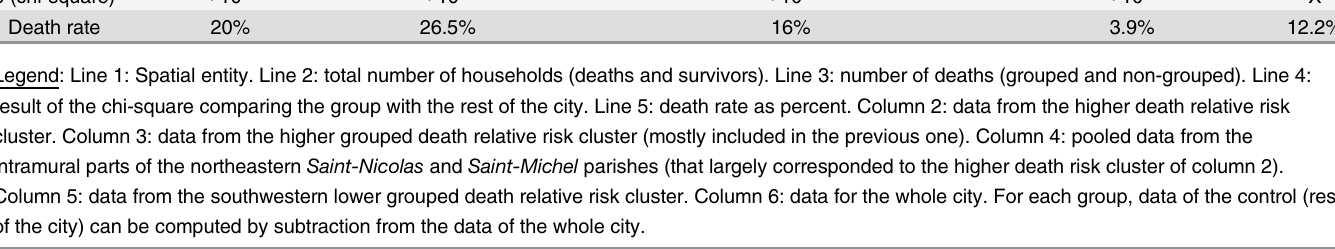
of the city) can be computed by subtraction from the data of the whole